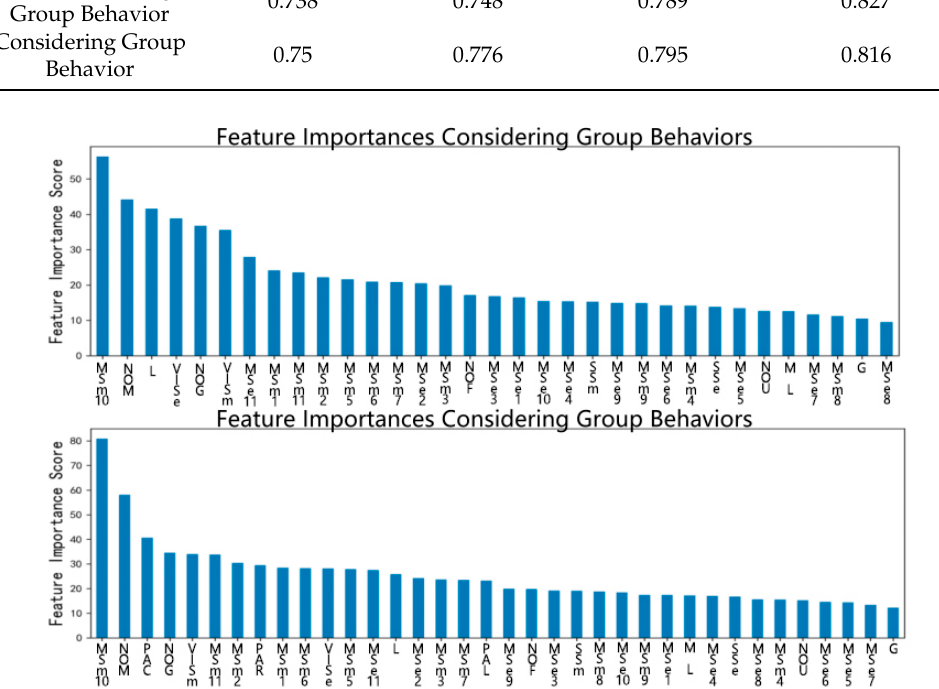
Figure 3. Feature importance based on XGBoost.